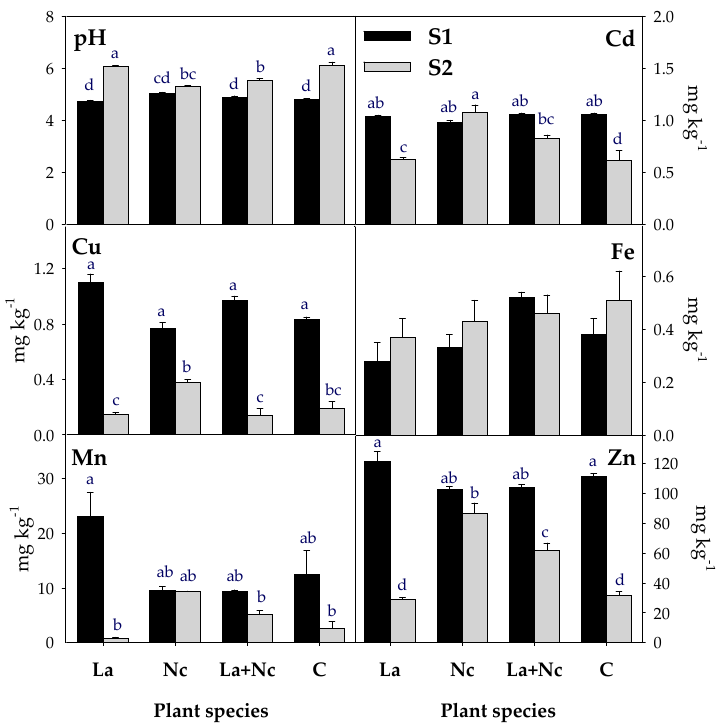
Figure 4. Concentrations of metals extracted with 0.1 M CaCl 2 in the soils where L. albus (La), N. caerulescens (Nc), or L. albus and N. caerulescens (La + Nc) were grown and in the control (C) soils (with no plants) (mean values (DW) ± standard error). Bars marked with different letters indicate significant differences at p < 0.05, according to Tukey’s test. Bars without letters indicate that no significant differences were found ( p > 0.05) between those samples.